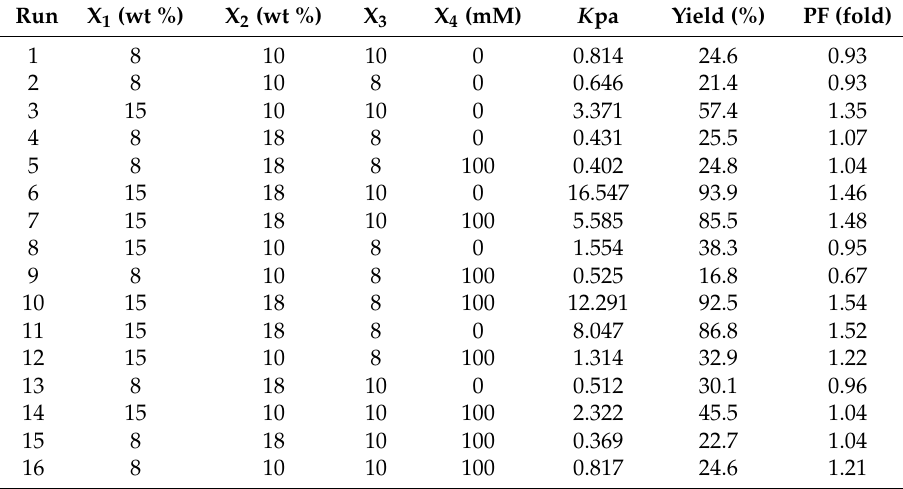
Table 1. Experimental design and results of response